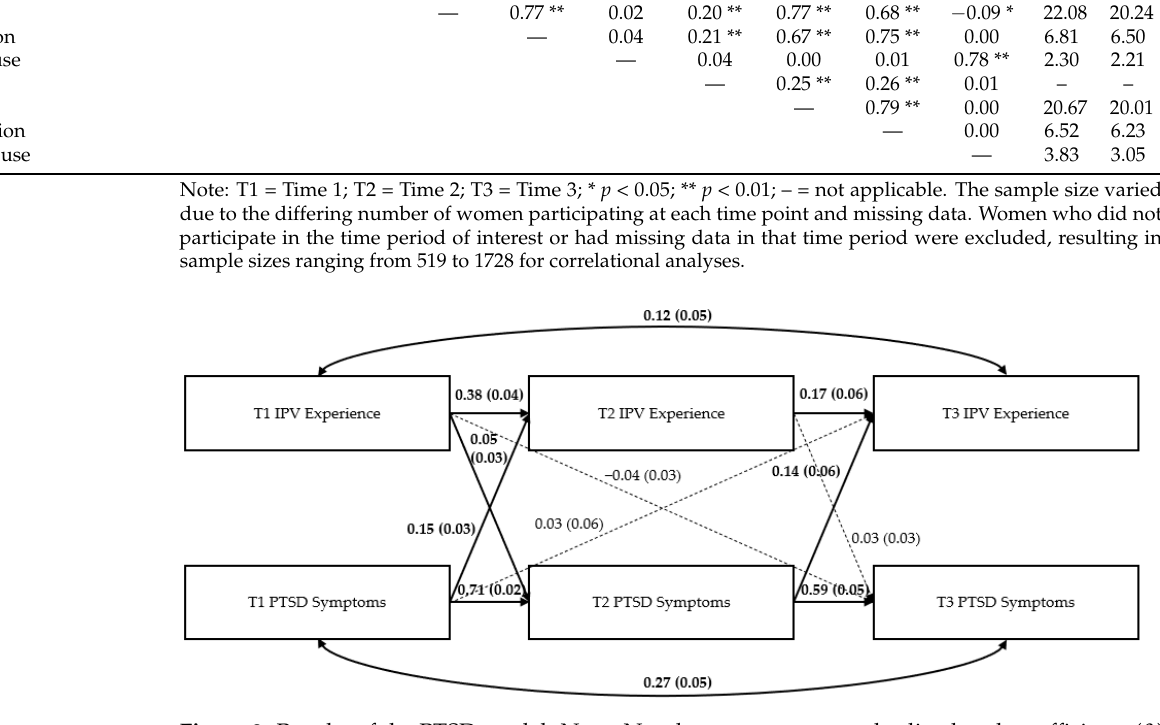
Figure 2. Results of the PTSD model. Note: Numbers represent standardized path coefficients ( β ) and standard errors (SE) in parentheses. Bolded lines and coefficients are significant; dotted lines are nonsignificant ( p > 0.05); n = 1839 women due to missing data on some variables.